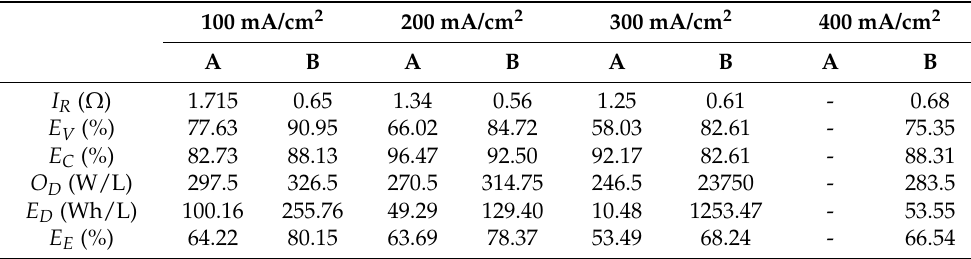
Figure 5. Charge and discharge data. ( a ) Constant-current charge/discharge experiment for untreated electrode. ( b ) Con- stant-current charge/discharge experiment of treated electrode. Table 2. Constant Current Charge and Discharge Data (A: Untreated Carbon Felt; B: Treated Carbon Felt).